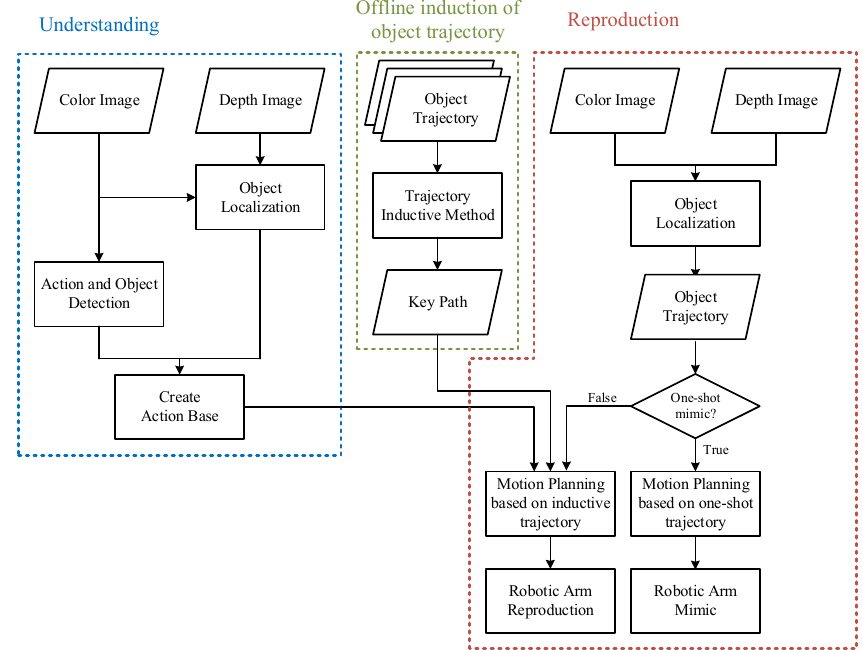
Figure 2. Flow chart of the proposed LfD robotic system.